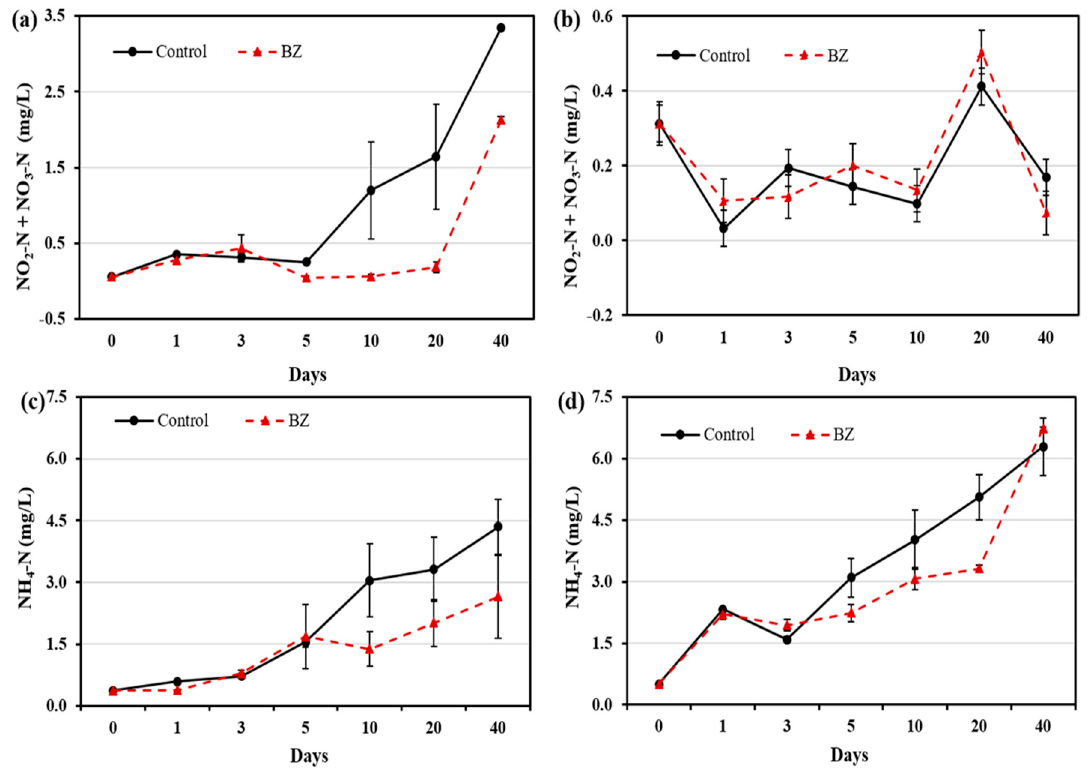
Figure 3. Changes in nitrogen-containing compound concentration at different times in ( a ) overlying water ( b ) pore water, and changes in ammonium concentration at different times in ( c ) overlying water and ( d ) pore water. All analytical measurements were performed in triplicate and error bars indicate the standard deviation of the mean.